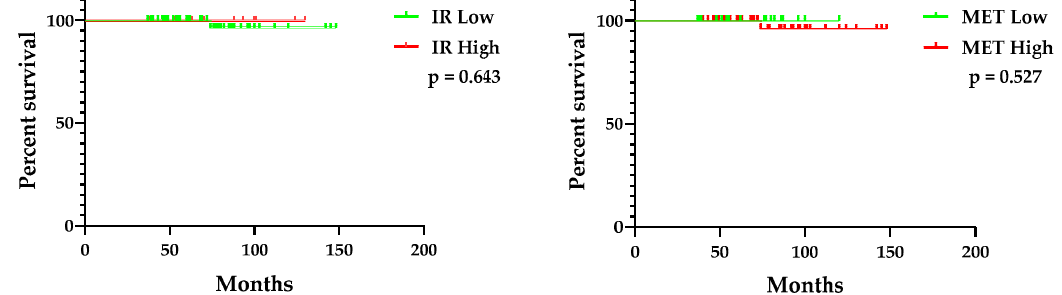
Figure 3. Overall survival of breast cancer patients by expression status of IR (left panel) and c-MET (right panel). IR, insulin receptor. 288